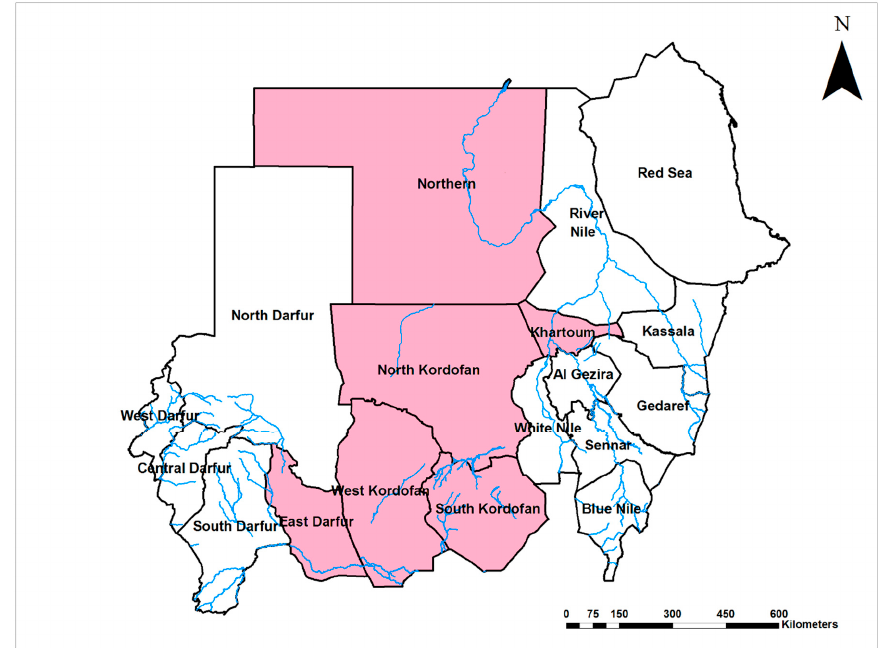
Figure 7. Map of Sudan showing the prevalence of Crimean-Congo hemorrhagic fever virus infections (Pink). infections